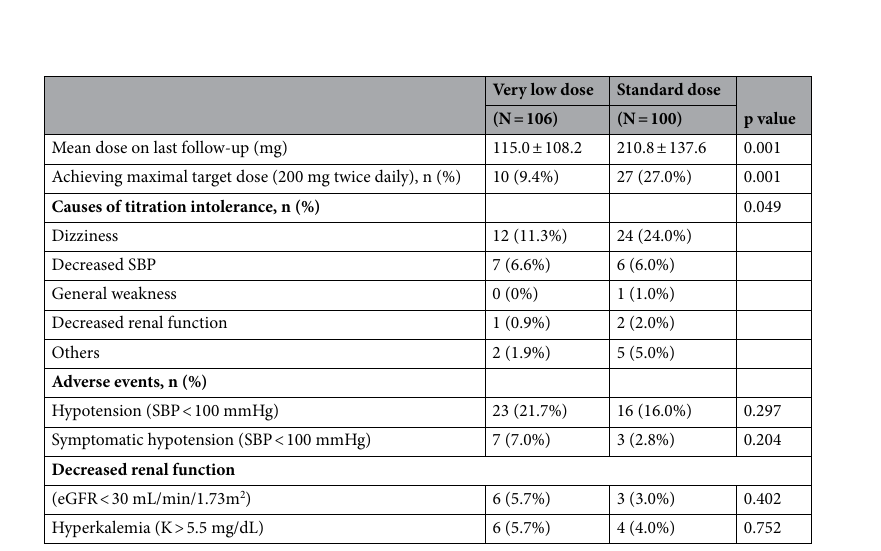
Table 3. The achievement rate of the maximal target dose of sacubitril/valsartan, tolerability, and adverse events. SBP systolic blood pressure, eGFR estimated glomerular filtration rate.